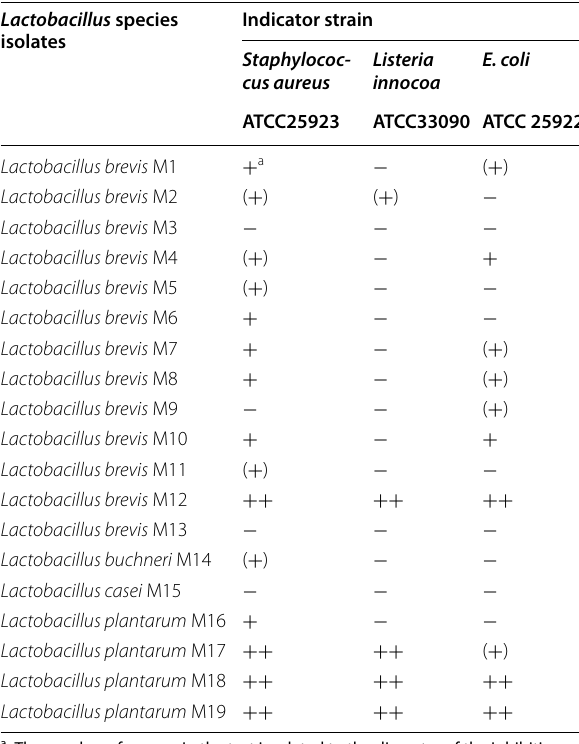
Table 6 Antagonistic activity (well assay) of Lactobacillus genus isolates against indicator bacteria